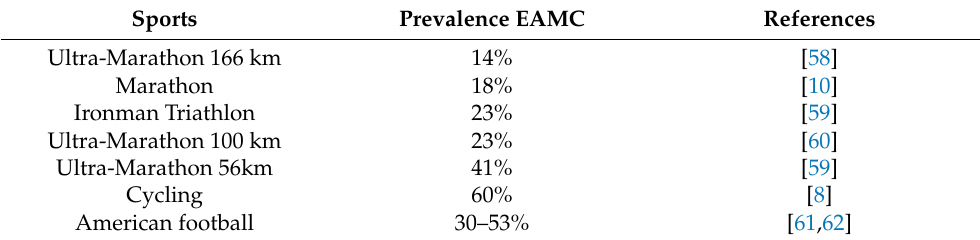
Table 2. Prevalence of exercise-associated muscle cramps (EAMC) in